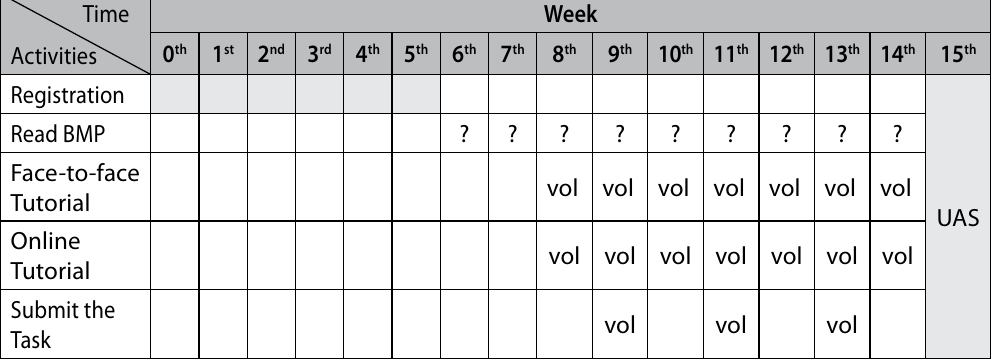
Table 5 Learning process of non PGSD and non PPS Student by